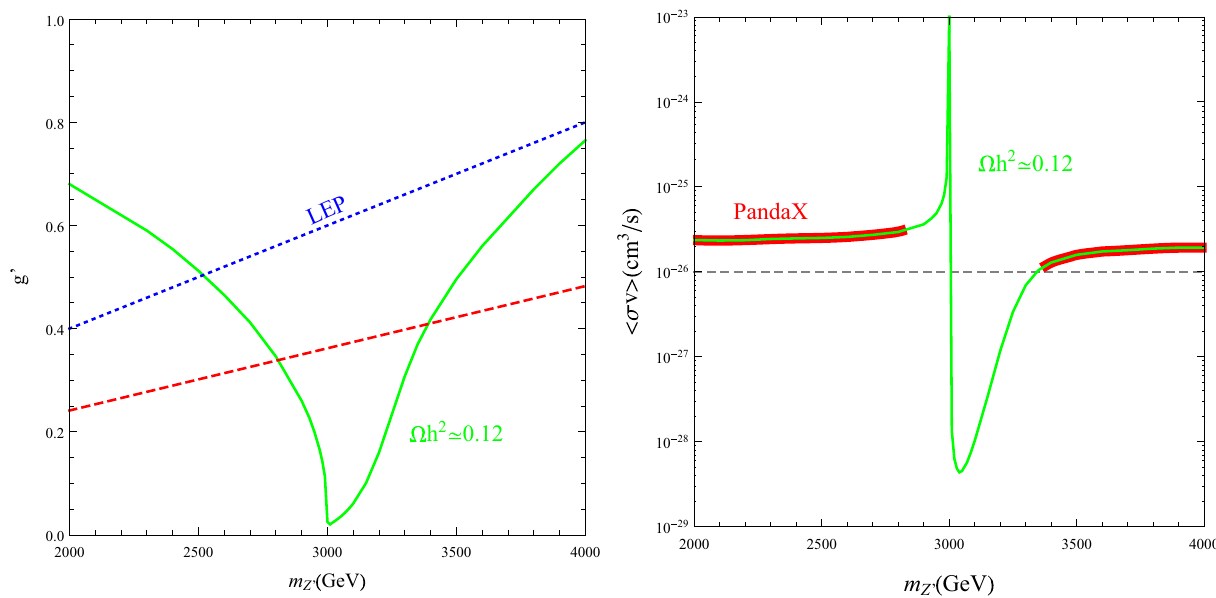
Fig. 3 Left: allowed region for DAMPE DM in the g (cid:3) – m Z (cid:3) plane. The green line delimit the relic density in the 1 σ range: (cid:17) h 2 = 0 . 1199 ± 0 . 0027,whileblueandredlinecorrespondtoLEPandPandaX